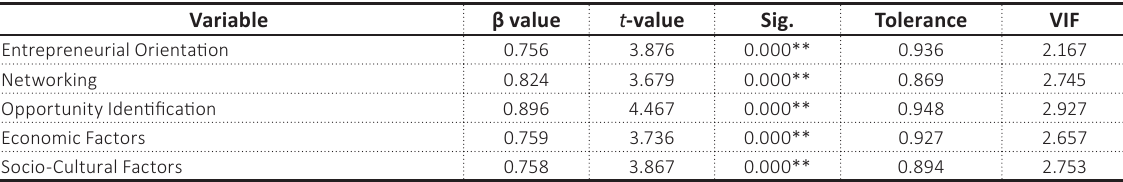
Table 3 confirms H3: opportunity identification